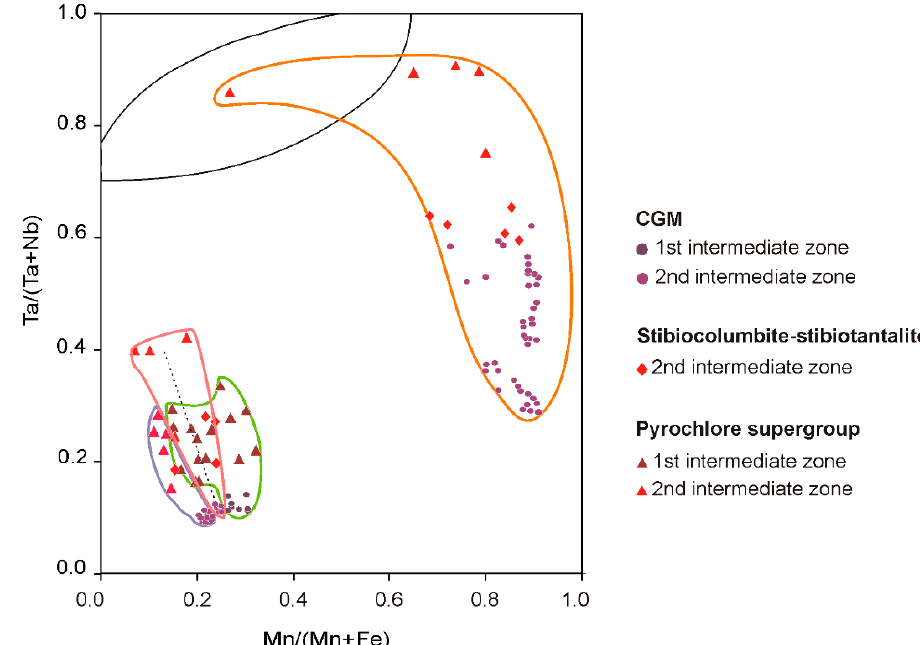
Figure 24. Composition of CGM, pyrochlore supergroup, stibiocolumbite and stibiotantalite of selected crystals of type-IV pegmatites from Giraúl plotted in the CGM quadrilateral.